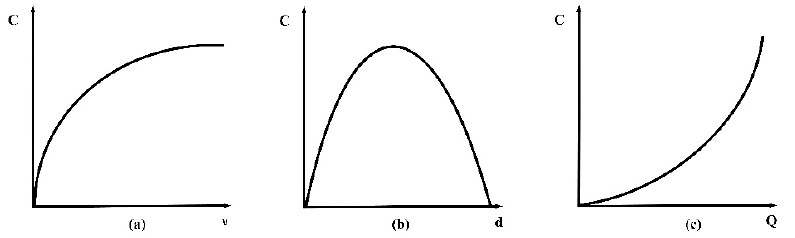
Figure 3. Relationship between the PM 2.5 concentration change at the target point. Assuming that Q is unchanged, the relationship between the change in v and C is shown in ( a ). Assuming that Q is unchanged, the relationship between the change in d and C is shown in ( b ). Assuming that v and d remain unchanged, the relationship between Q and C is shown in ( c